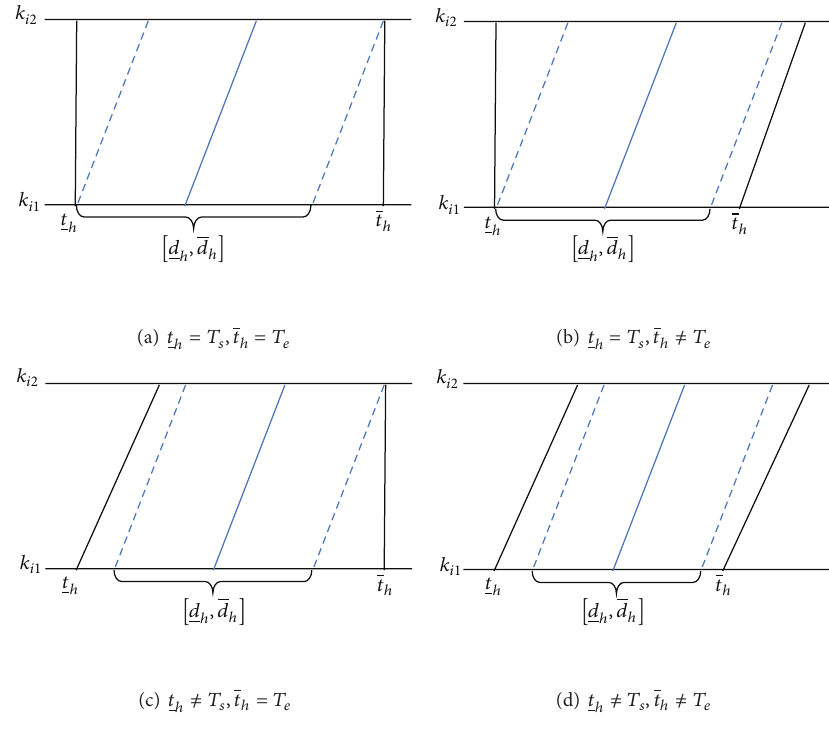
Figure 4: Train’s feasible departure time range in subperiod [𝑡 ℎ ,𝑡 ℎ ]